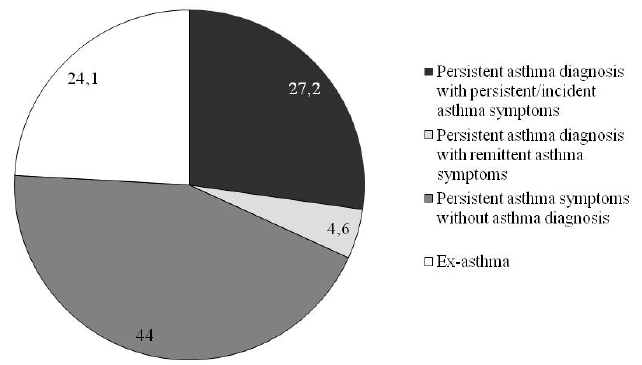
Figure 3. Longitudinal asthma patterns.